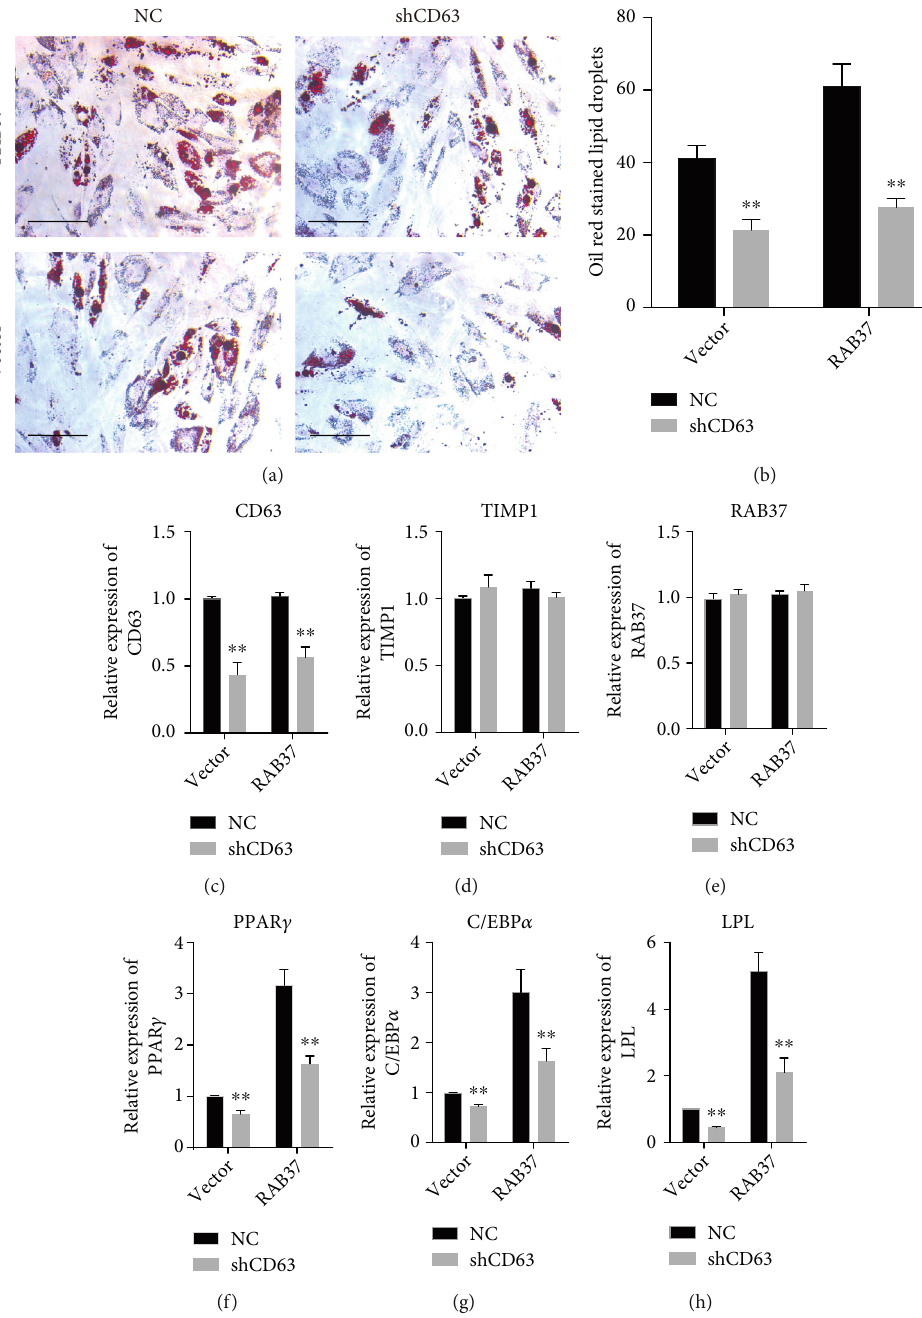
Figure 6: Knockdown of CD63 compromised RAB37-mediated proliferation and adipogenic di ff erentiation. The lentivirus expressing shRNA targeting CD63 (shCD63) was used to inhibit endogenous expression of CD63 in RAB37-ADSCs. Lentivirus expressing a scramble RNA was used as control. Adipogenic di ff erentiation was evaluated by Oil Red O staining (a); scalebar = 300 μ m . Oil Red O- stained hADSCs in six random views were counted (b), n = 6 . The expression of TIMP1 (c), PPAR γ (d), C/EBP α (e), and LPL (f) was examined by qRT-PCR, n = 3 . Data are presented as mean ± SD . ∗∗ p < 0 : 01 ; lv-scramble vs.